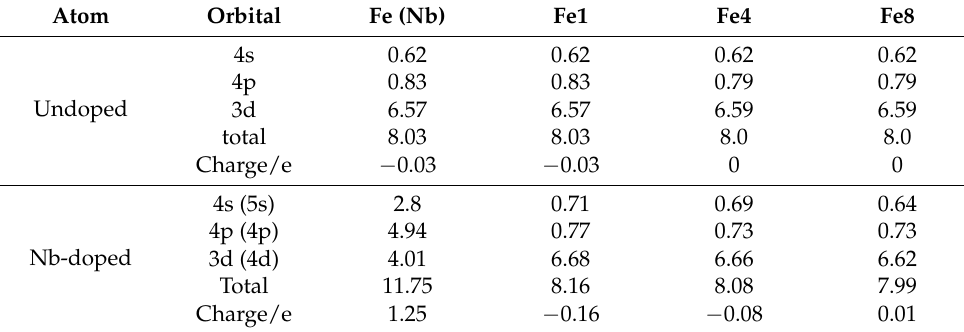
Table 5. Mulliken electronic populations of Nb and its neighbor Fe